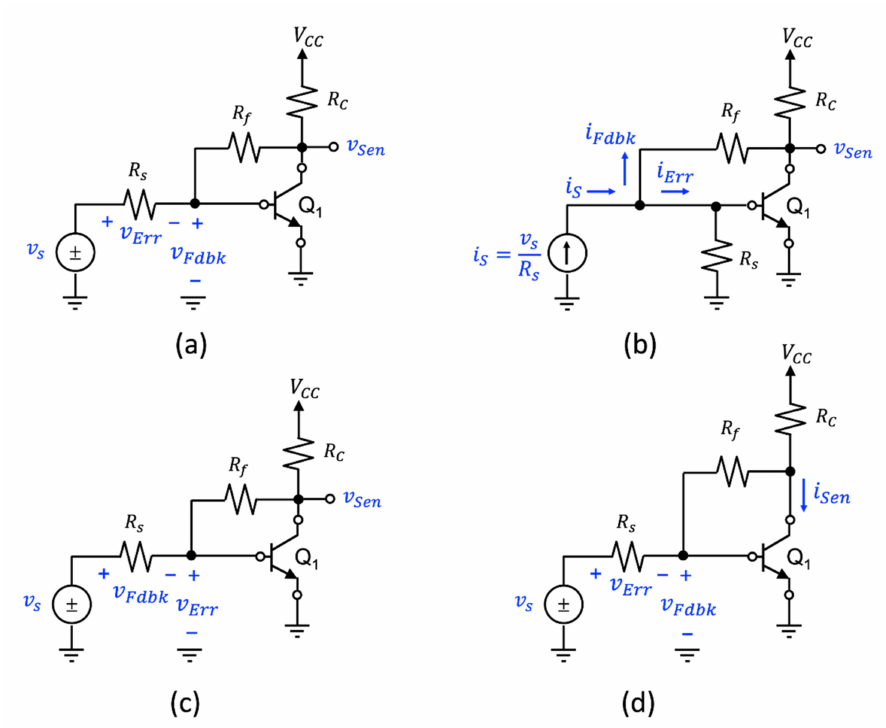
Figure 14. Different feedback formulation for a CE BJT amplifier with resistive feedback: ( a ) voltage-mixing/voltage-sensing compliant arrangement with feedback variable highlighted in blue, ( b ) through a Norton transformation, the CE amplifier is rearranged into an equiva- lent current-mixing/voltage-sensing compliant topology, ( c ) interchanging the feedback and er- ror signal designations, and ( d ) selecting the sense signal as the collector current rather than the collector